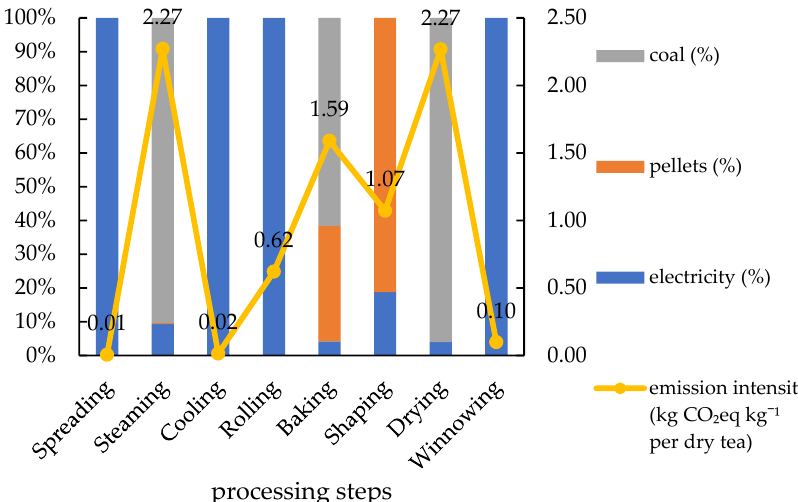
Figure 5. Carbon footprint of the processing stage and proportions of each energy source used at different steps.